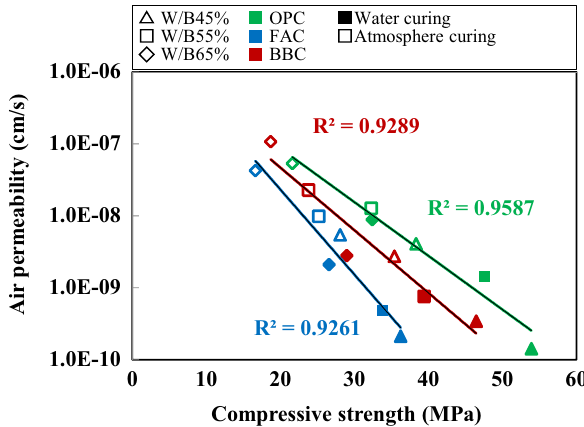
Fig. 4 Air permeability versus compressive